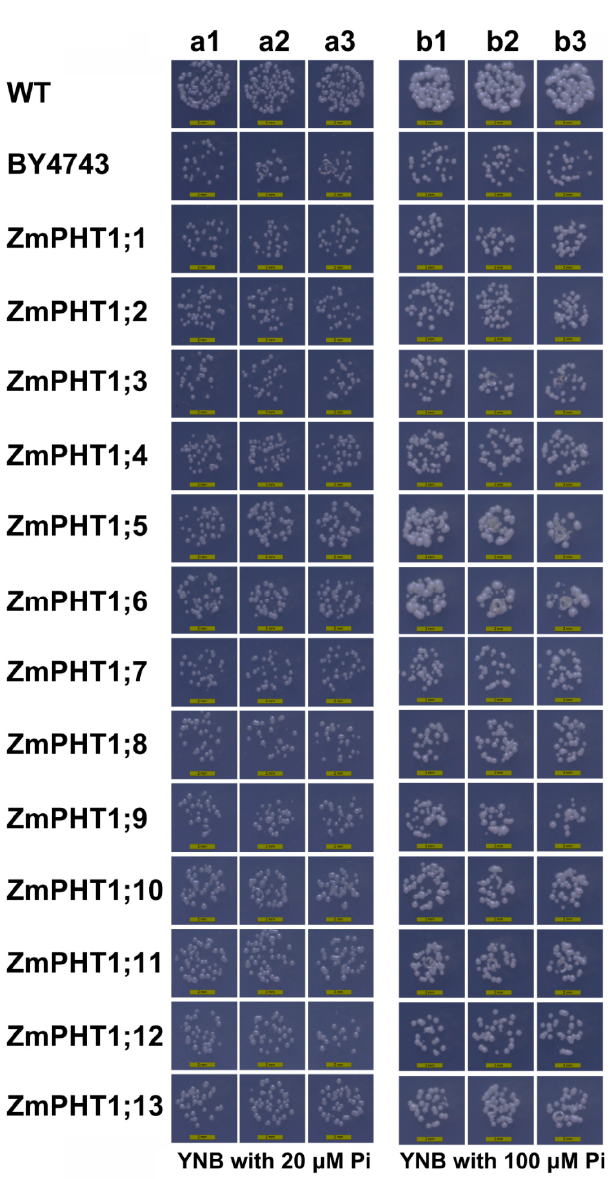
Figure 5. Functional characterizations of ZmPHT1s in a yeast inorganic phosphate (Pi) transport mutant. Under two Pi conditions three repeat experiments were set respectively. Repeat experiments were represented by a1, a2, a3 under 20 µM and b1, b2, b3 under 100 µM Pi conditions.